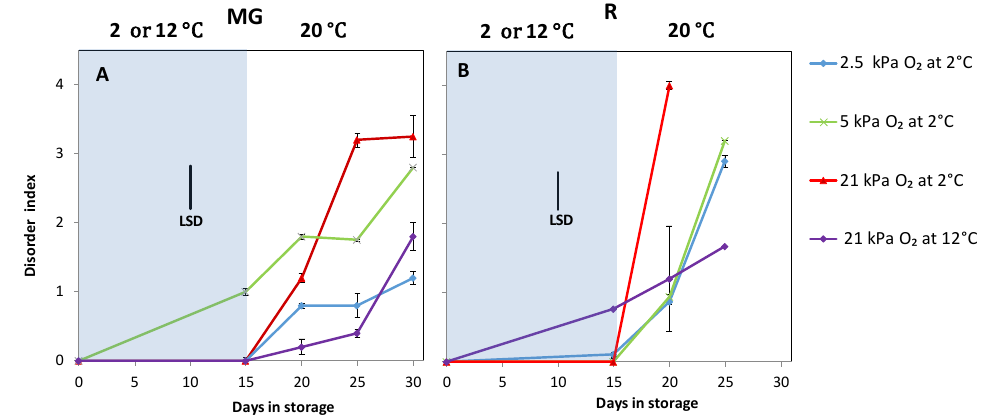
Figure 1. Chilling injury symptoms as indicated by the disorder index of MG ( A ) and R ( B ) tomatoes during cold storage at 2 or 12 °C (blue area) and subsequent shelf-life at 20 °C (white area). Blue, green, red and purple lines and symbols indicate 2.5, 5, 21 kPa O 2 (low oxygen control) applied during storage at 2 °C and 21 kPa O 2 at 12 °C (temperature control), respectively. The average decay index with indicated standard error is shown for five tomatoes. LSD values ( p < 0.05) are indicated per panel. Disorder in MG fruit was determined by averaging the values of the pitting and uneven ripening index; disorder in R fruit was determined by the average decay incidence.